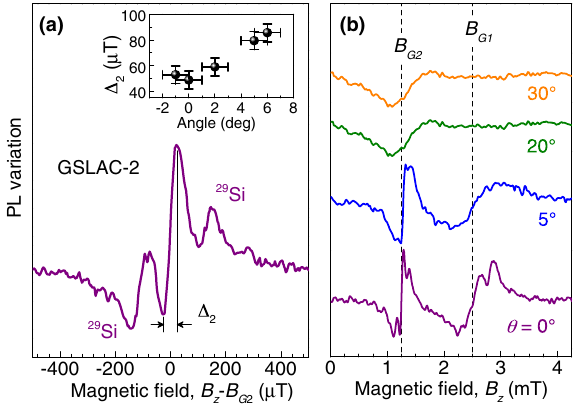
FIG. 5. (a) Lock-in detection of the PL variation in the vicinity 1 . 25 mT), performed in 4H-SiC with of GSLAC-2 ( B G 2 ¼ natural isotope abundance. Satellite resonances are due to the hyperfine interaction with 29 Si nuclei. Inset: Variation of the peak-to-peak width as a function of the magnetic field orienta- tion. (b) PL variations at GSLAC-1 (at B ) and GSLAC-2 (at G 1 B ) for different magnetic field orientations with respect to the G 2 c -axis (polar angle θ ). T ¼ 300 K. The nonzero peak-to-peak width for θ ¼ 0 ° is ascribed to magnetic fluctuations of the environment (nuclear spins and paramagnetic impurities) and magnetic field alignment uncertainty